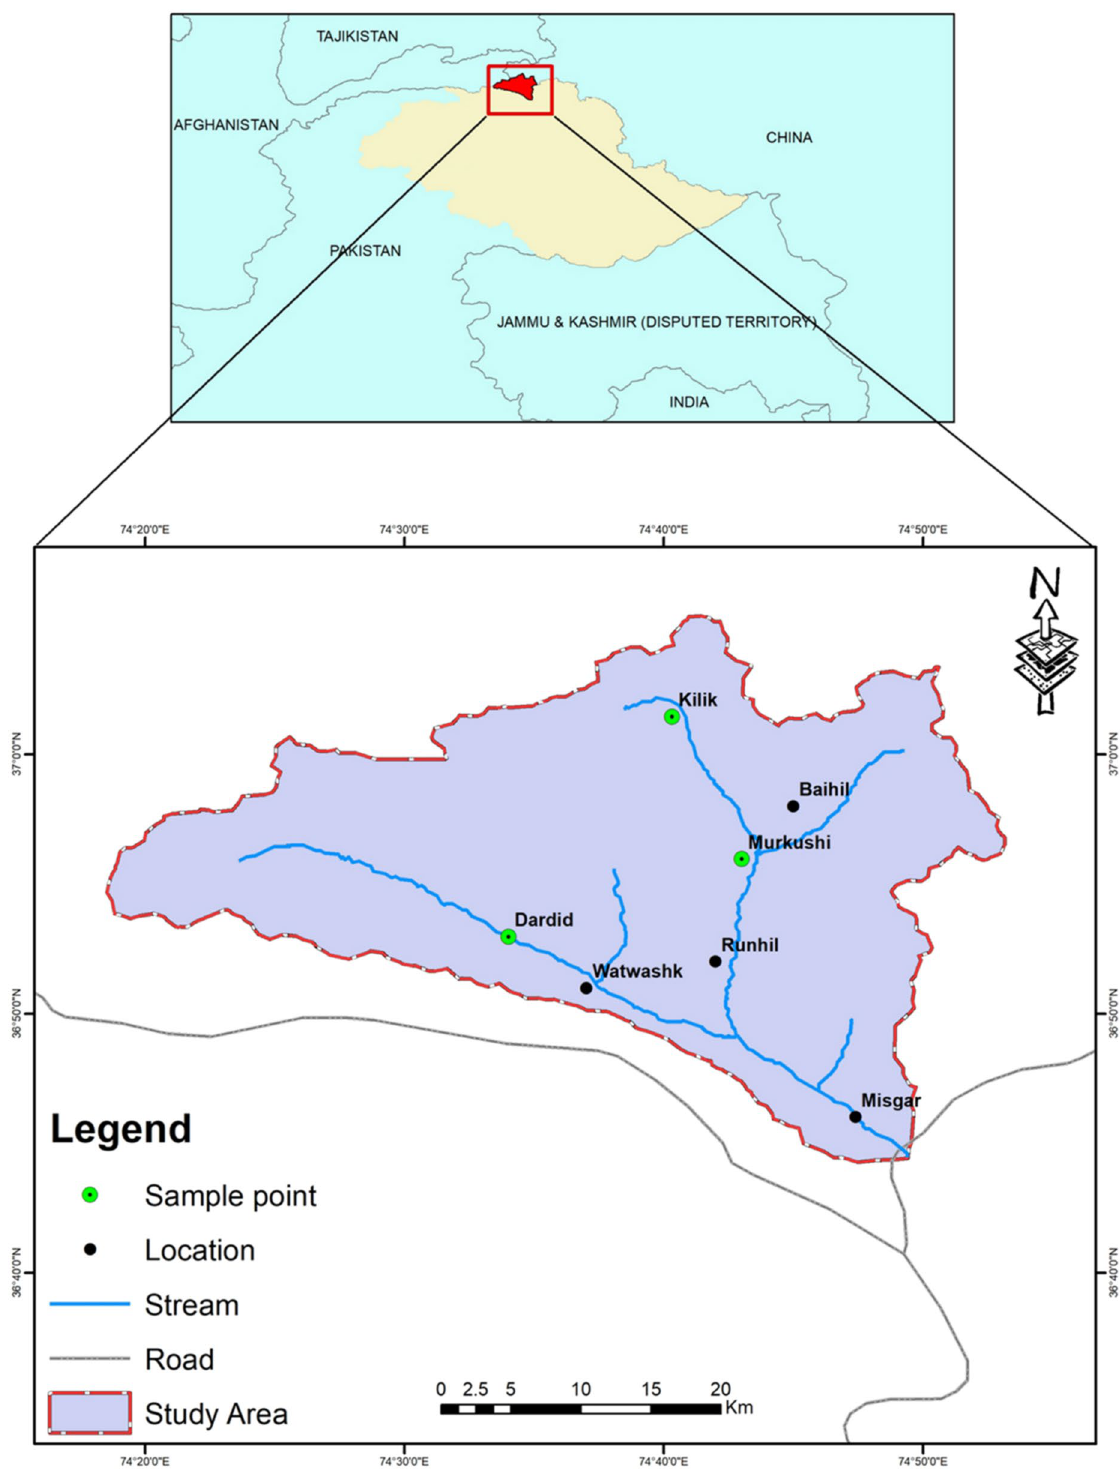
Figure 1. Map of study area, showing locations of livestock depredation. Map is developed in ArcGIS Version 10.8 (www. esri.